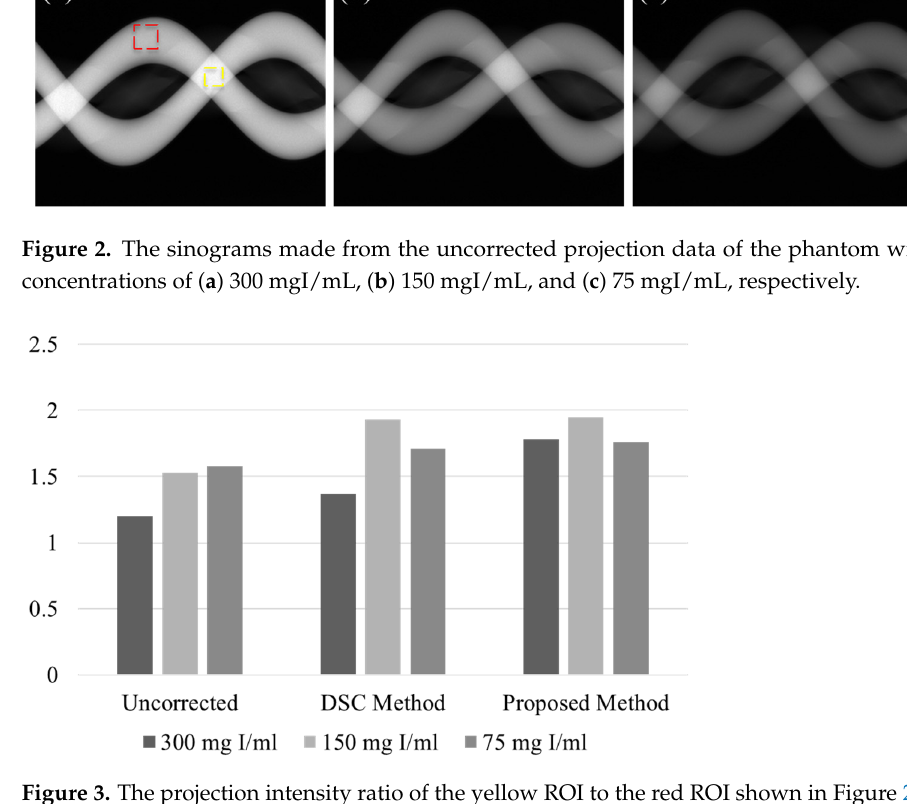
Table 1. The projection intensity at the ROI and the projection intensity ratio of the yellow ROI to the red ROI.